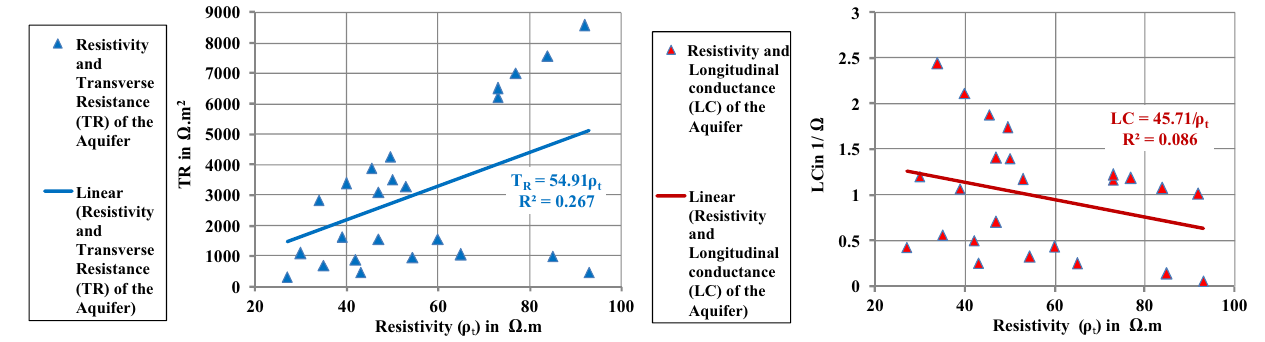
2 (left) and the longitudinal conductance T R ) in Ω m